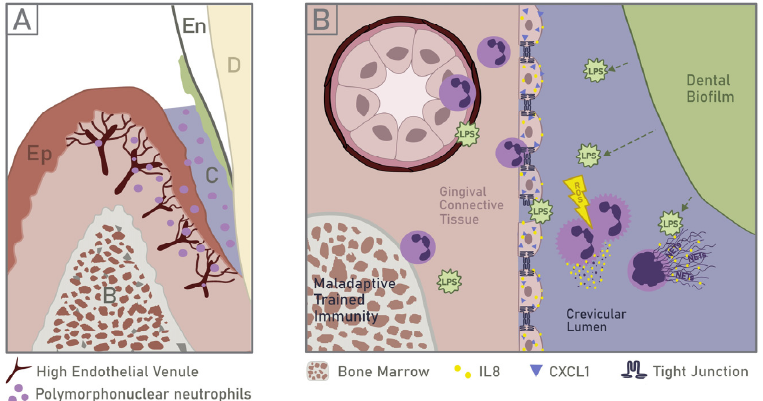
Figure 2. Gingival barrier dysfunction through topical factors: ( A ) a scheme of the periodontium in periodontitis; Ep—epithelium, En—tooth enamel, B—bone and bone marrow, C—crevice, D—dentin; ( B ) neutrophil recruiting and TJ disruption via LPS, neutrophil and bacterial proteases, bacterial toxins, and